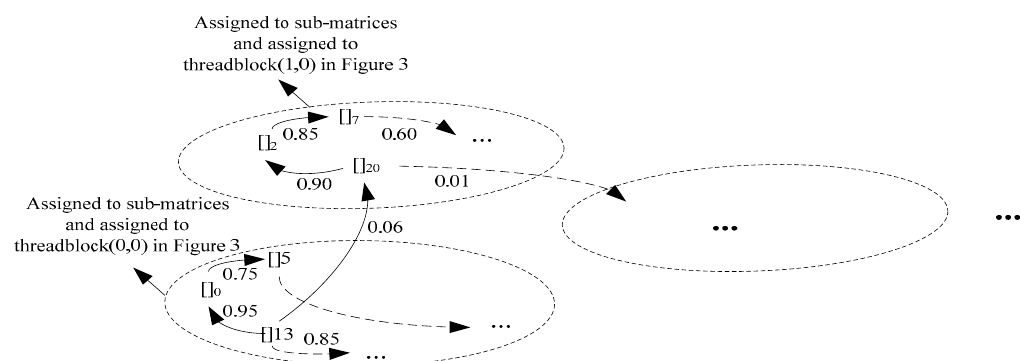
Figure 6. The proposed membrane-weighted network and classification. Membranes having higher communication rates are organized within the same groups (dashed ellipses). The number of membranes per group should satisfy Equation (4), and the membranes assigned to the sub-matrices, NTx × NTy, will be executed in the same thread block.